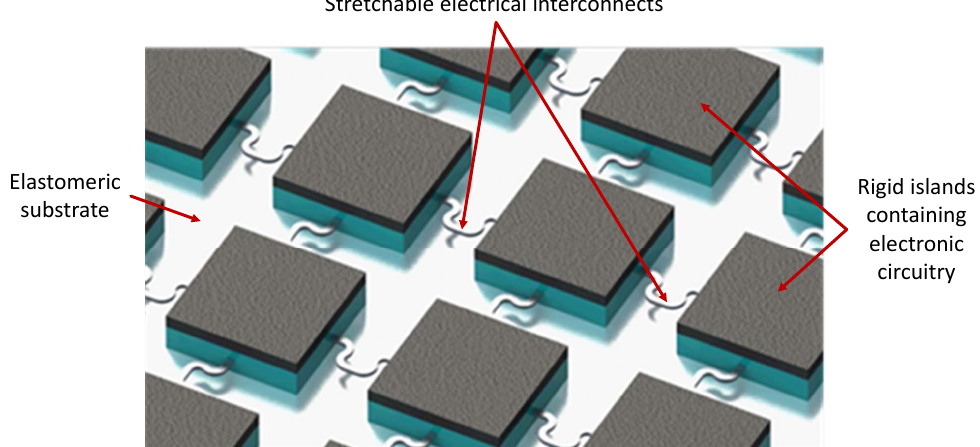
Figure 1. A conceptual illustration of a hybrid stretchable electronics circuit. The rigid islands that contain the electronic functionality are attached to a stretchable substrate and interconnected by (e.g., horse-shoe shaped) free-standing metal interconnects. The overall stretchability of the circuit is mainly determined by the stretchability of the free-standing